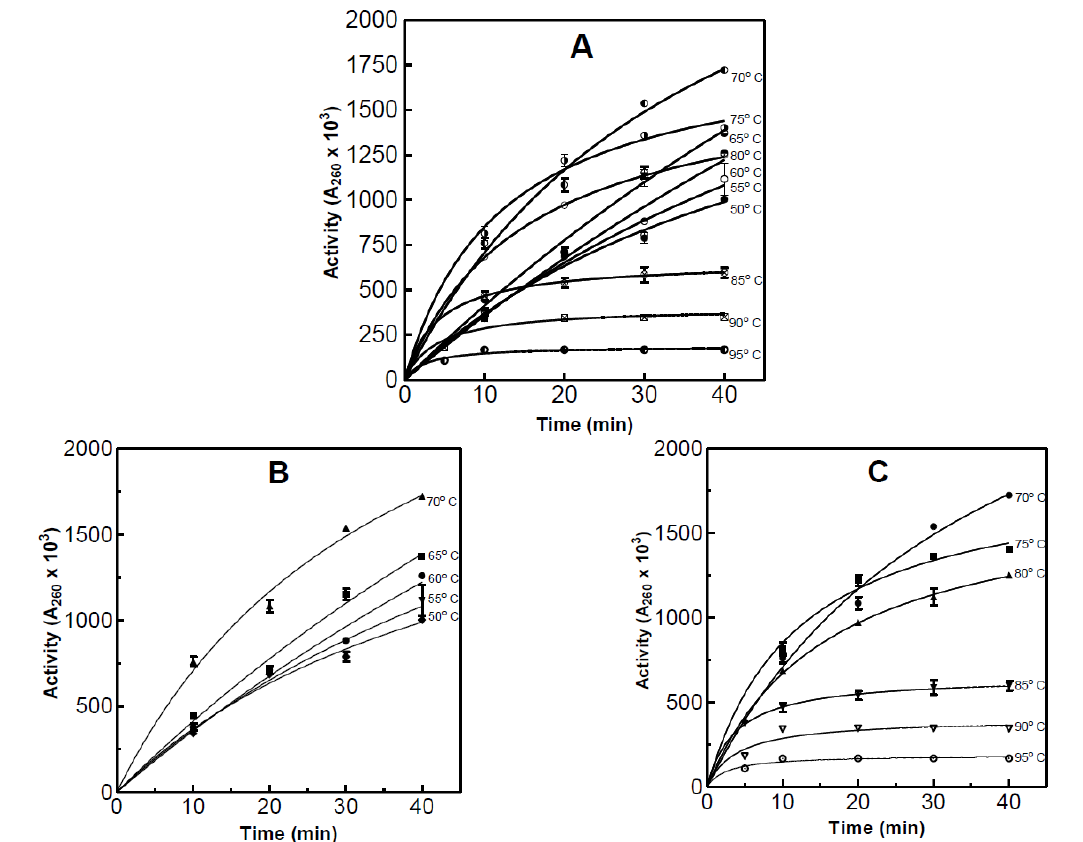
Figure 4. The effect of temperature on the activity of the partially purified RNase. The plots are as follows: ( A ) plot of all of the temperatures assayed for activity; ( B ) plot of the temperatures 50–70 °C; and ( C ) plot of the temperatures 70–95 °C. Activity was measured using the acid soluble assay which was performed in triplicate.